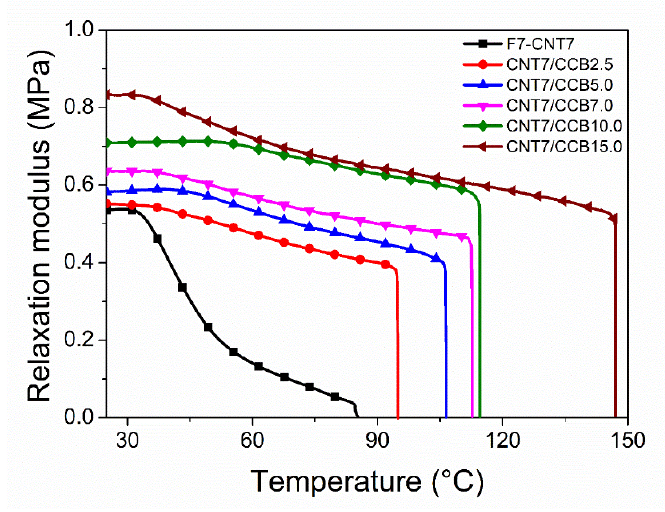
Figure 7. Relaxation modulus as a function of temperature of ENR–FeCl 3 filled with CNTs (F7-CNT7) and CNT–CCB hybrid filler with various CCB loadings at 2.5, 5.0, 7.0, 10.0 and 15.0 phr.